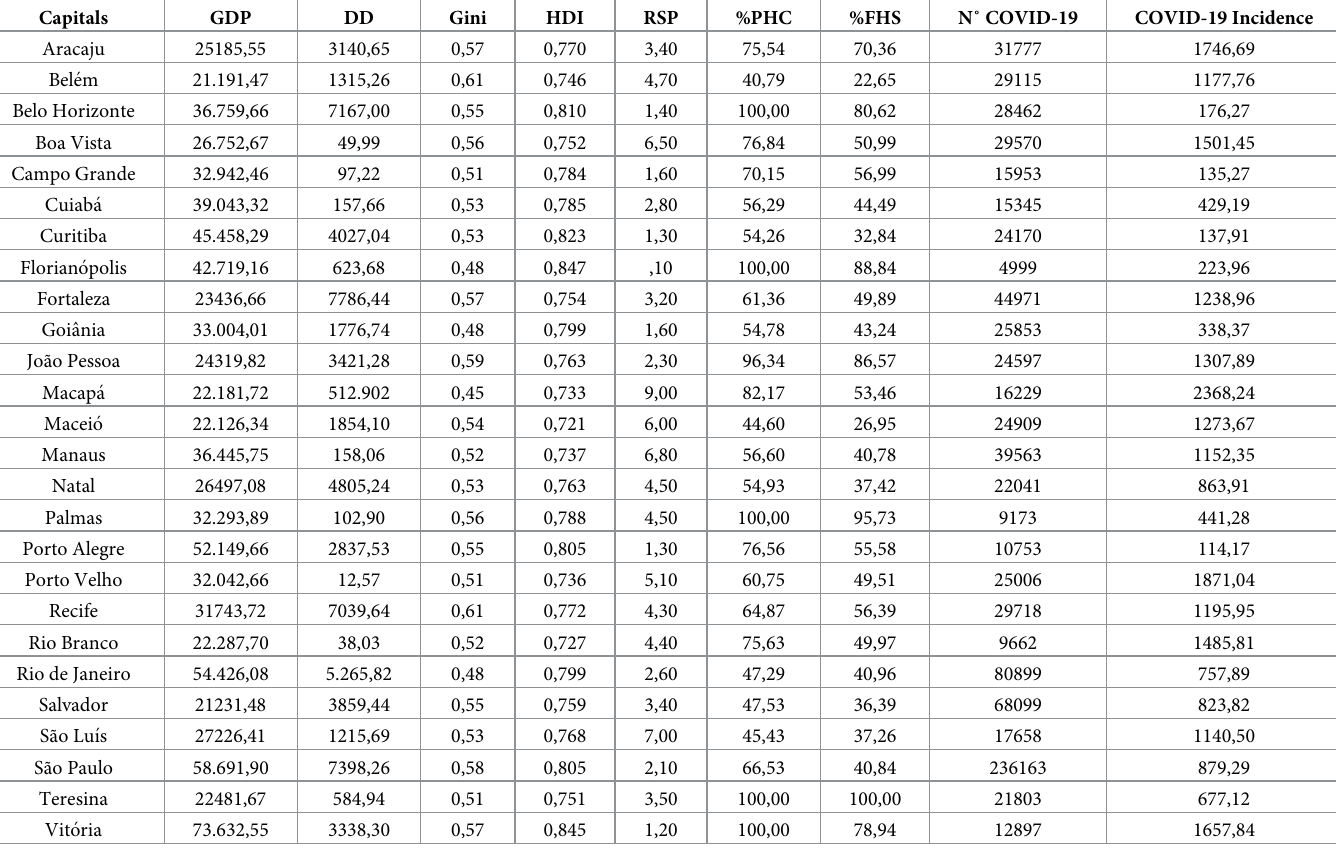
Table 1. Description of the socioeconomic characteristics of the capitals of Brazilian federative units in 2020.